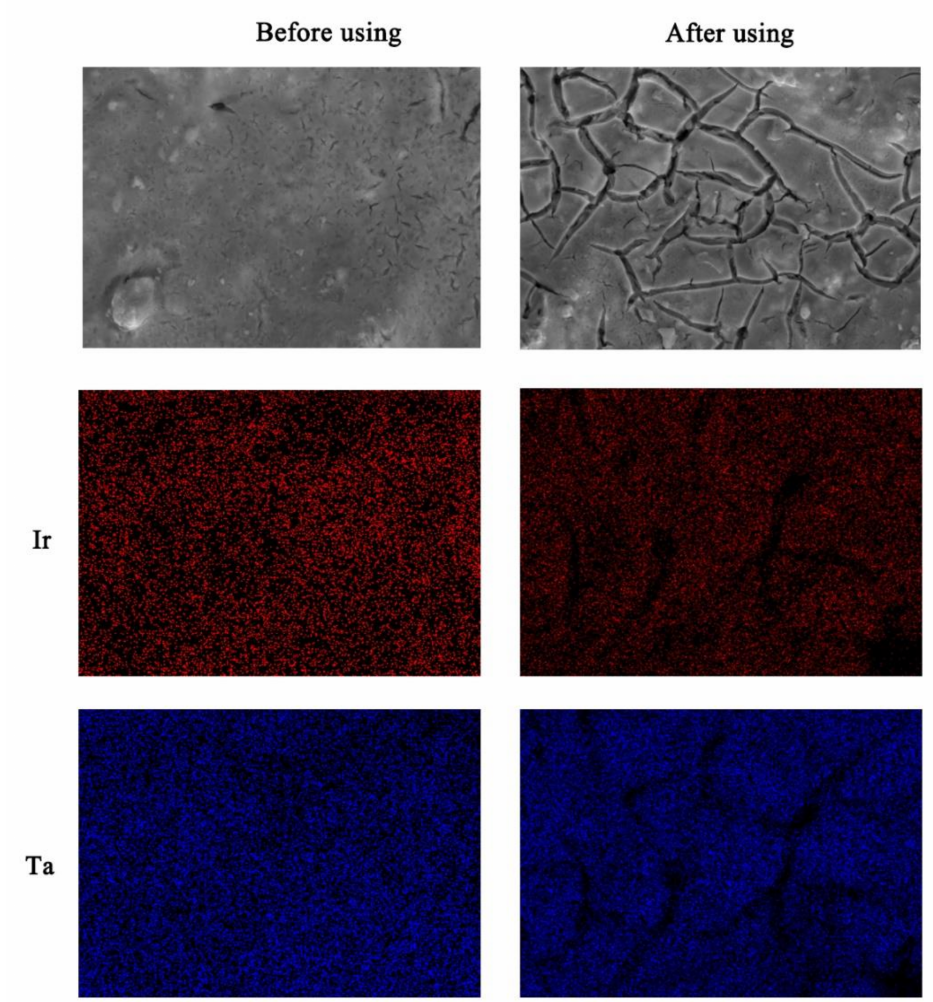
Figure 1. SEM and EDS patterns of the Ti/Ta 2 O 5 -IrO 2